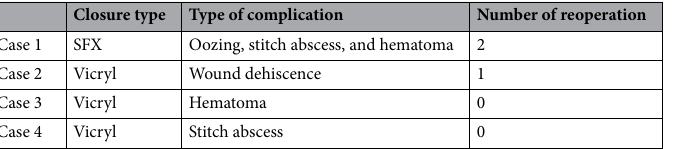
Table 4. Wound related complications. SFX, fascial closure with Stratafix; Vicryl, fascial closure with